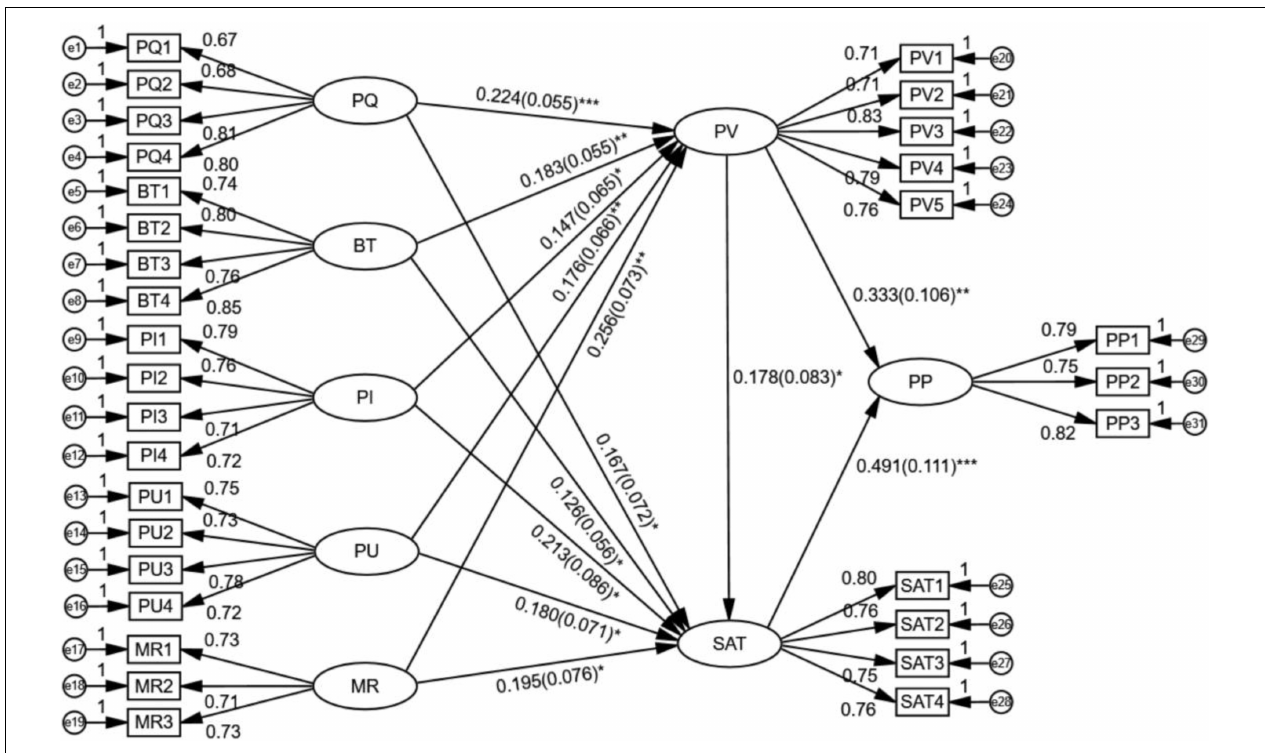
FIGURE 2 | Results of structural equation model analysis. * p < 0.05, ** p < 0.01, *** p < 0.001.